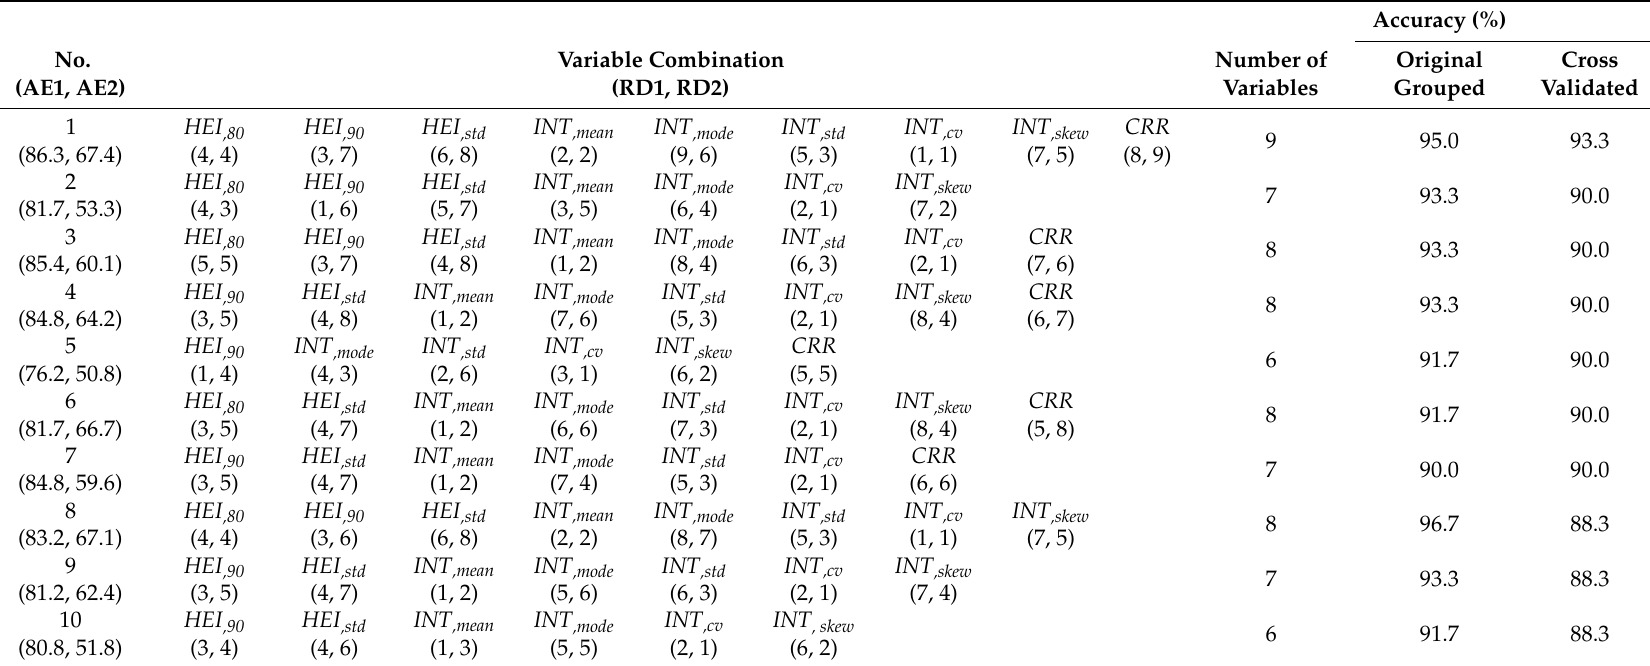
Table 3. Accuracy assessment results of multiple linear discriminant analysis by various combinations (upper ranked 10